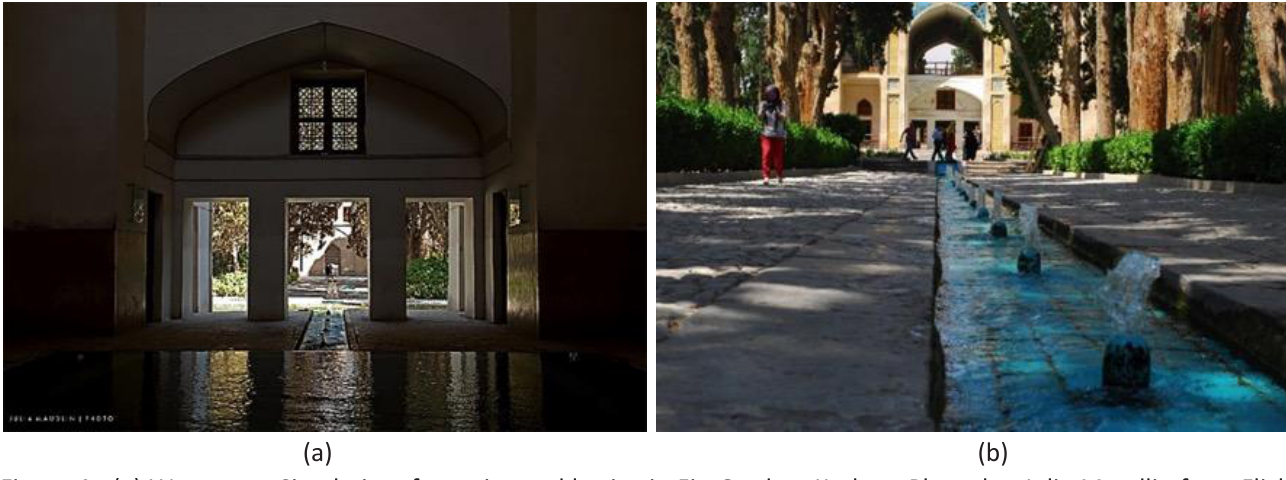
Figure 4. (a) Water way Circulation, fountains and basins in Fin Garden, Kashan. Photo by: Julia Maudlin from Flickr; (b) Water way Circulation, fountains and basins in Fin Garden, Kashan. Photo by: Shudderbug from Flickr